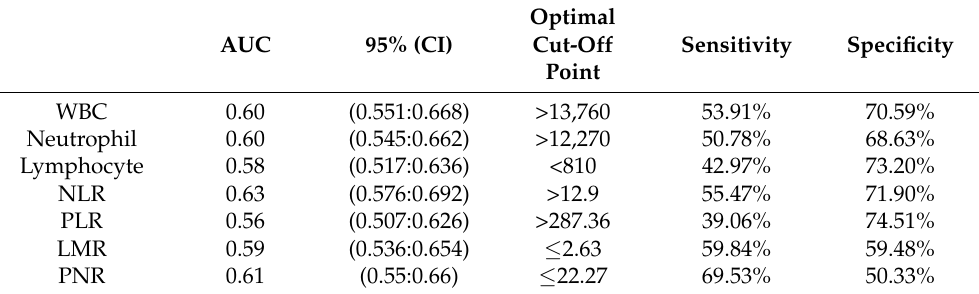
Figure 1. ROC curve analysis. Table 3. Sensitivity and specificity of WBC, neutrophil, lymphocyte, NLR, PLR, and LMR for predicting brain